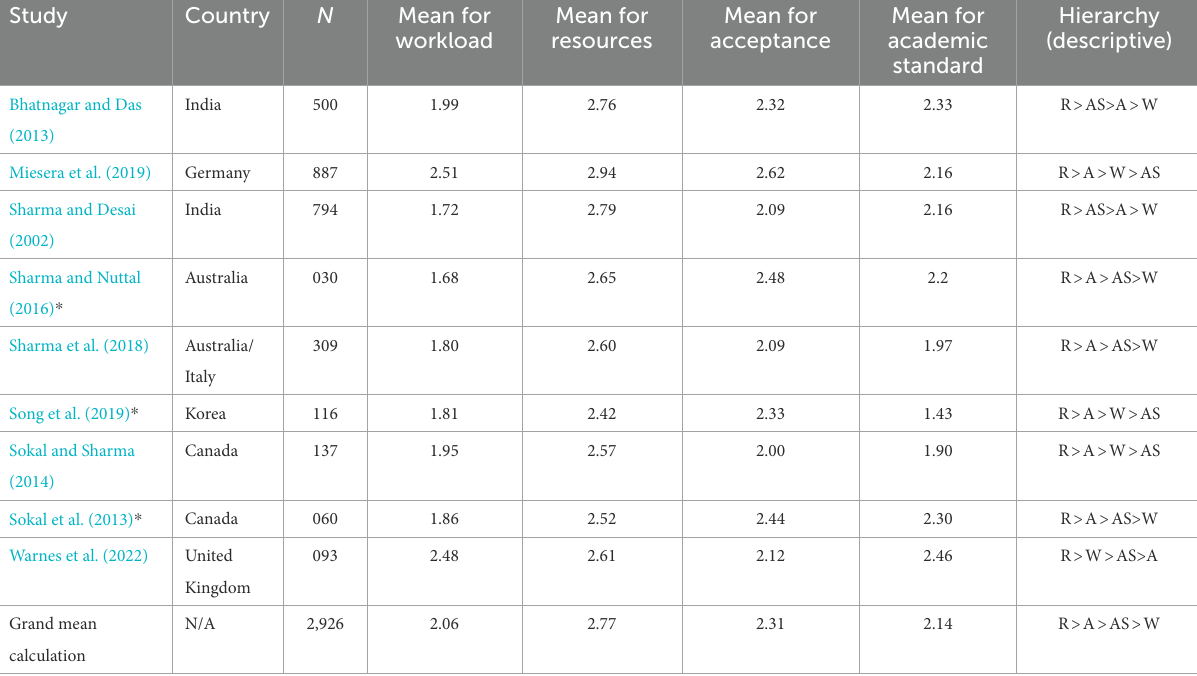
TABLE 1 Synthesis of studies that have used the CIES and provide information regarding the means for each